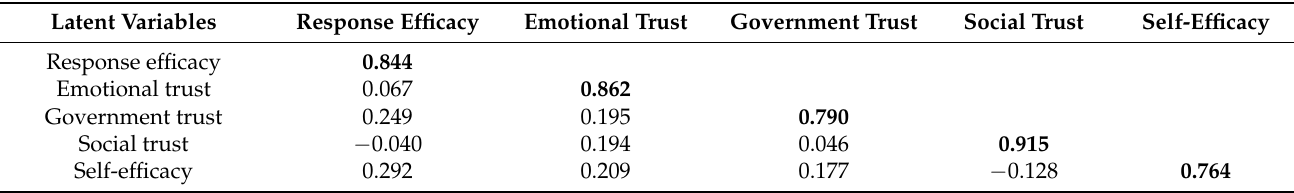
Table 5. Pearson correlation matrix and average extraction.